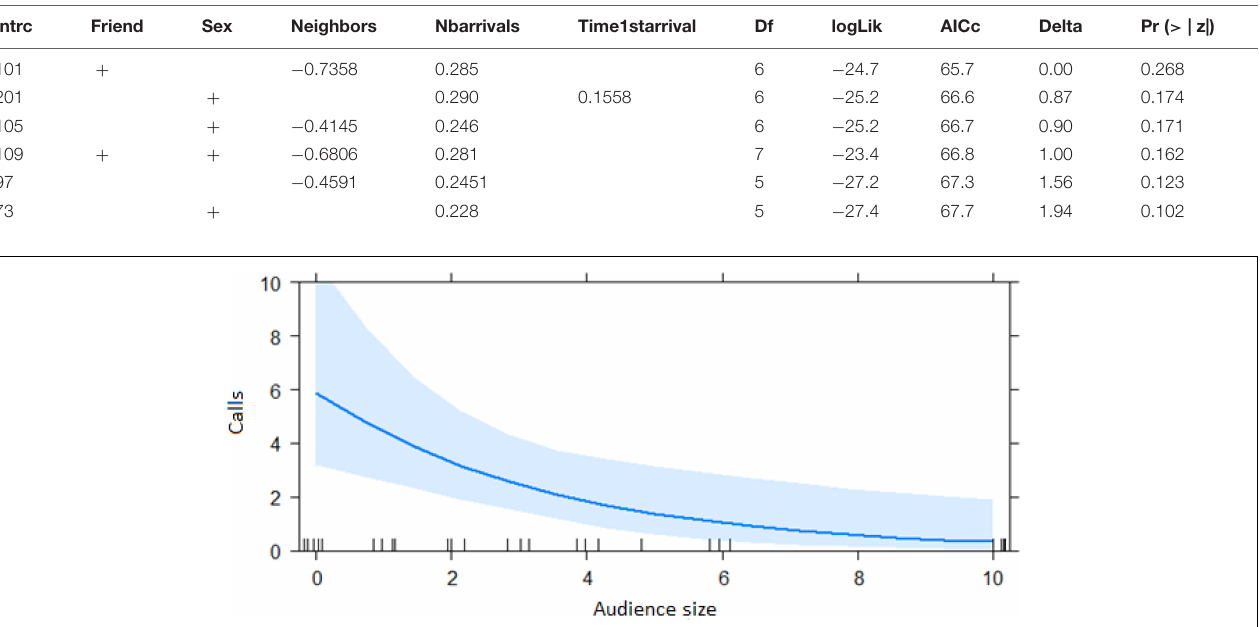
TABLE 2 | Model selection table for the LMM for the number of alarm calls of ignorant individuals encountering the snake.